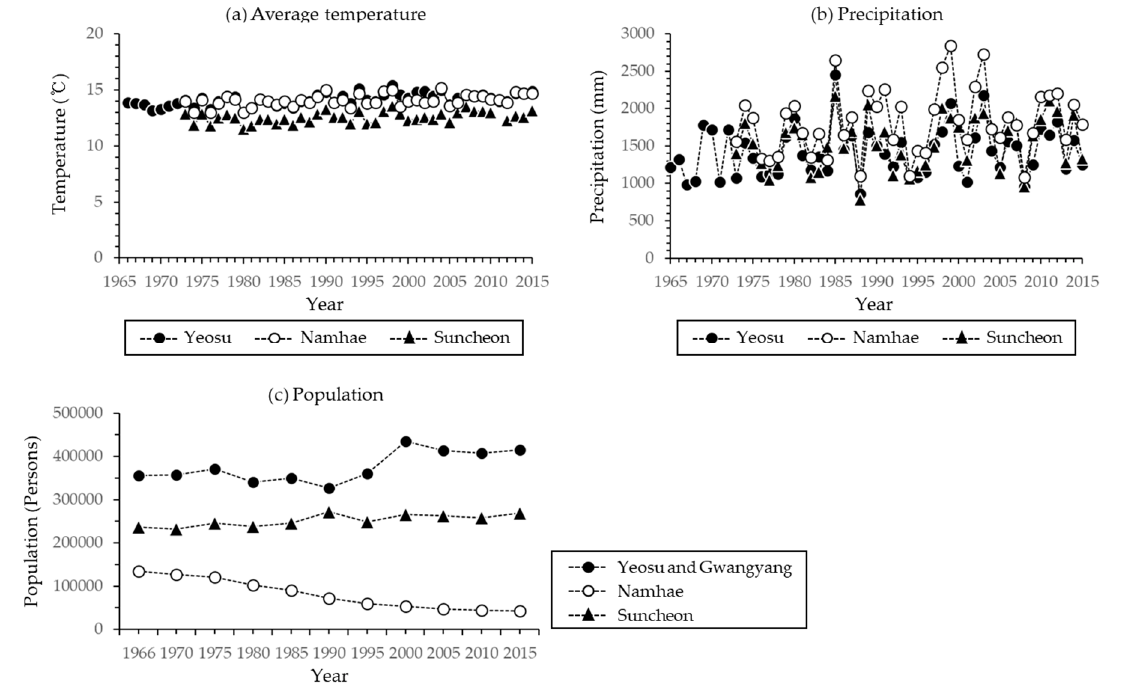
Figure 2. Historical changes of average temperature ( a ), precipitation ( b ), and population ( c ) at study areas. Table 1. Distances from industrial areas to study sites and average Hg concentrations in tree rings at Yeosu, Namhae, and Suncheon sites between 1967 and 2014.